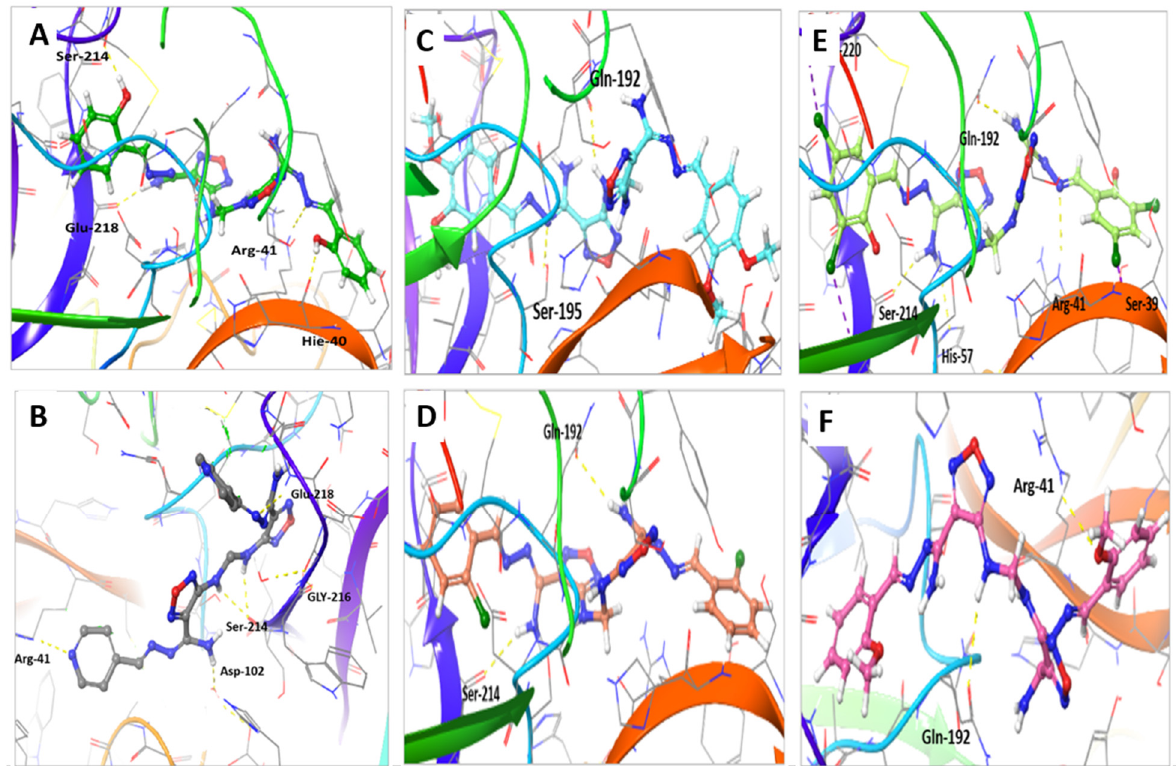
Figure 8. Molecular docking of compounds M1–5 compared to Compound 13 with TMPRSS2 (PDB:2OQ5) protein. ( A ) The interaction of Compound 13 (green stick) within the active site of TMPRSS2. ( B ) The interaction of M3 (gray stick) within the active site of TMPRSS2. ( C ) The interaction of M1 (cyan stick) within the active site of TMPRSS2. ( D ) The interaction of M2 (orange stick) within the active site of TMPRSS2. ( E ) The interaction of M4 (light green stick) within the active site of TMPRSS2. ( F ) The interaction of M5 (pink stick) within the active site of TMPRSS2.